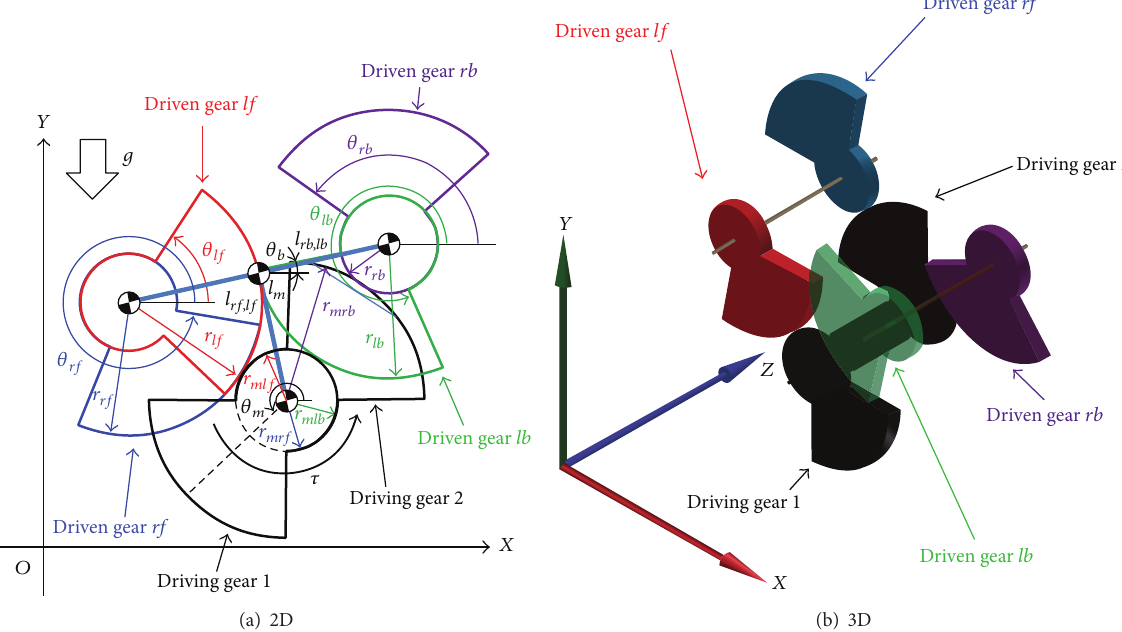
Figure 4: Schematic diagram of the gear system with parameters defined. The black-margined gear represents the driving gear, and the other gears represent the driven gears. The driving gear 1 and the driving gear 2 rotate synchronously.